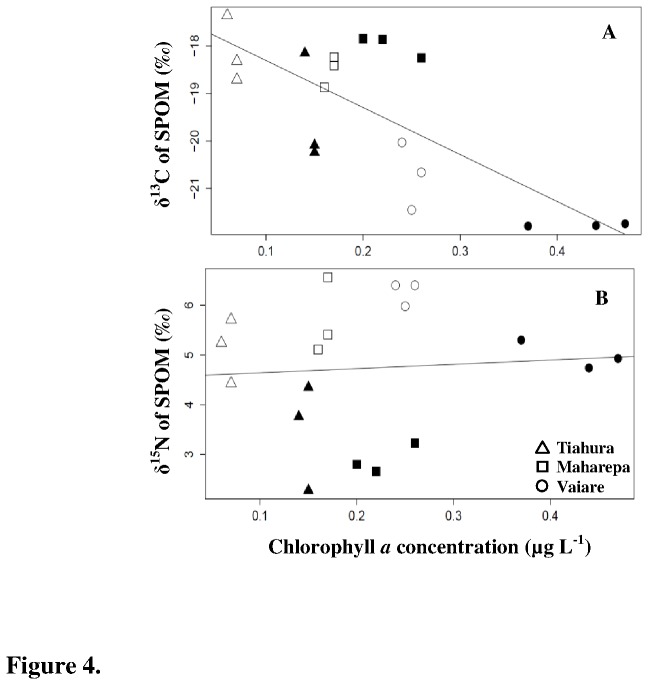
Environmental parameters: correlation between δ13C and δ15N of suspended particulate organic matter and chlorophyll a concentrations.Results are presented for all sites during both the wet (open symbols) and dry (black symbols) seasons, graphics A and B respectively. (A) δ13C = -17.22 - 9.88*Chla (r = -0.59,N = 18, p ≤ 0.01), (B) non significant correlation (r = 0.13, N = 18, p = 0.6).